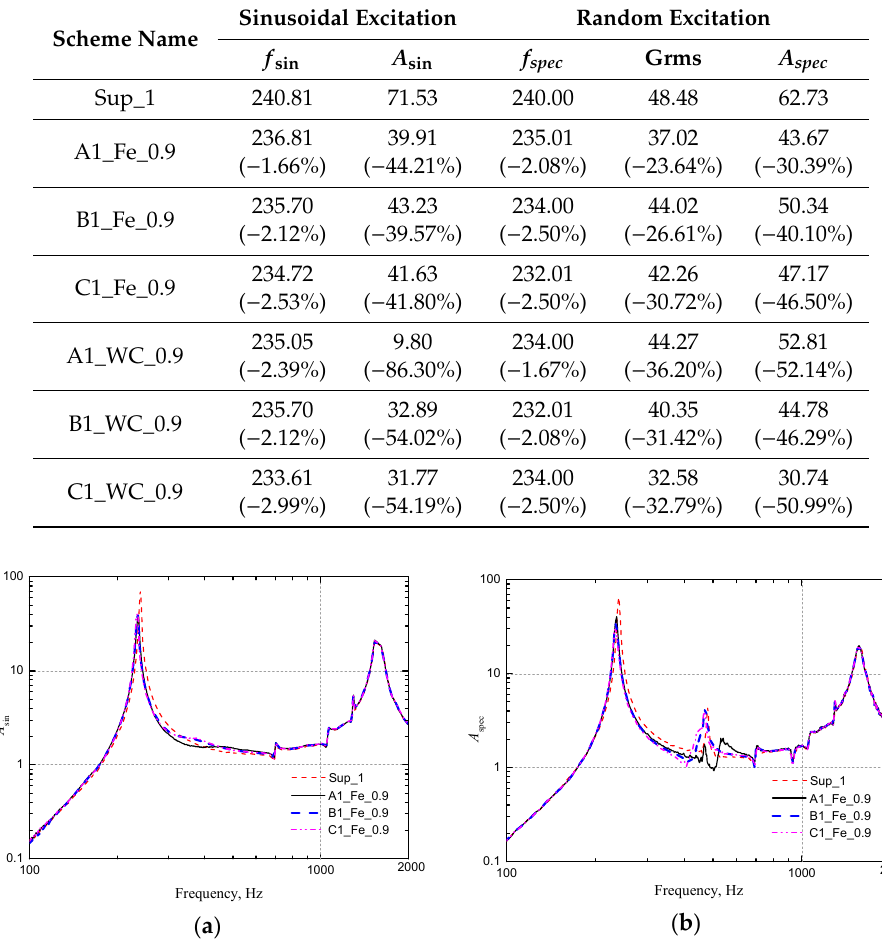
Table 6. E ff ect of layering in Z-direction of the cavity. Table 6. Effect of layering in Z-direction of the cavity.